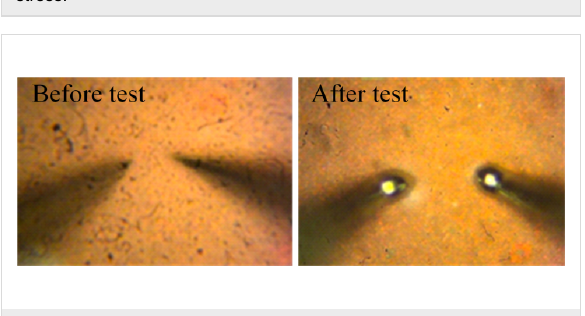
Figure 8: Optical microscope images showing two tungsten probes placed on a continuous ZnO nanoforest before (left) and after (right) a DC measurement test. The melting of the micrometer-sized probe tips during the electrical test suggests local temperatures above the melting point of tungsten (3422